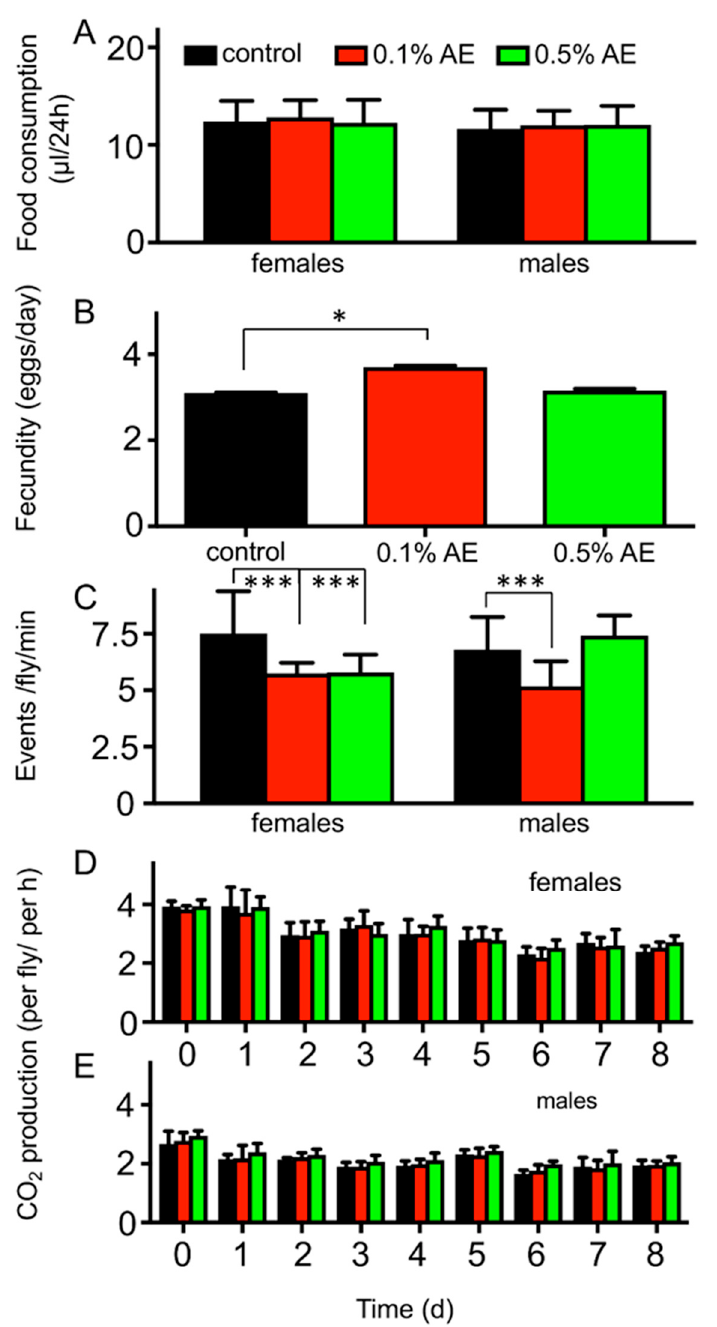
Figure 3. Quantification of food intake measured with a CAFE assay in female (left) and male (right) flies ( A ). Lifetime fecundity ( B ) of female flies subjected to normal food (black bars) or on normal food supplemented with 0.1% BAE (red bars) or 0.5% BAE (green bars). Overall physical activities ( C ) were quantified using the Drosophila Activity Monitor (DAM) system in a 24 h period for females (left) and males (right). Metabolic rates were measured in small cohorts of flies (3 per biological replicate), both in females ( D ) and males ( E ) subjected for the indicated times to the different media (control medium, black bars; 0.1% BAE, red bars; 0.5% BAE, green bars). Mean values ± SD are shown. n > 5 for each experiment. * p < 0.05, *** p < 0.001.